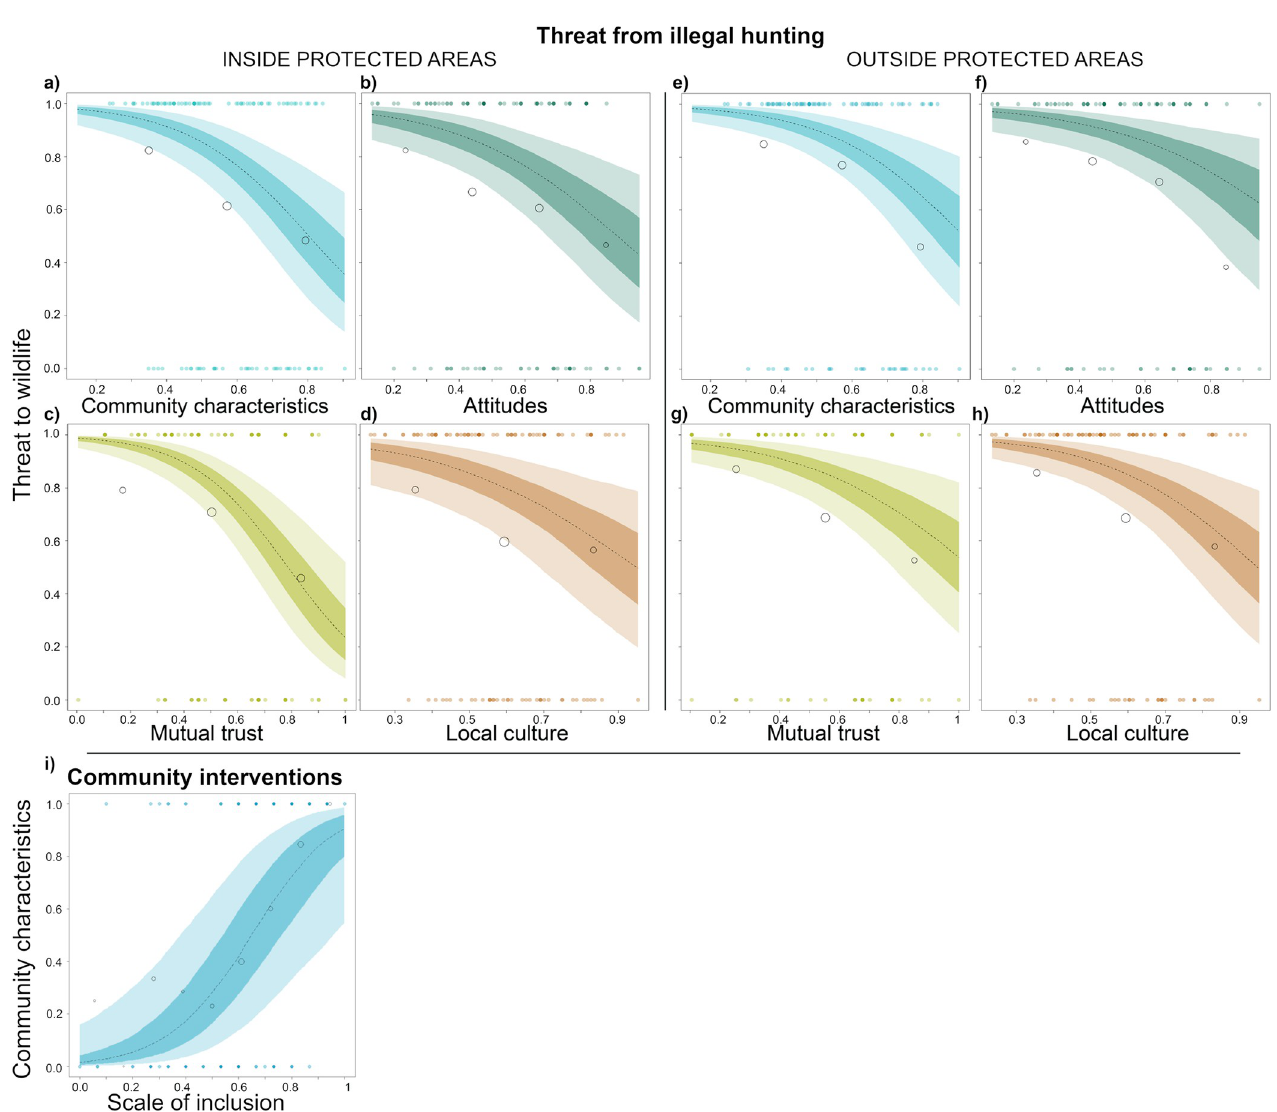
Fig 5. Where people hunt and what mitigates unsustainable hunting. Left panel: probability of high threat to wildlife by illegal hunting (killing/hunting/ poisoning) inside PAs related to (a) community characteristics and the separate components of the index community characteristics, (b) attitudes of local communities towards conservation, (c) mutual trust levels between park management and organisations, and (d) conservation-friendly local culture (the data underlying this figure can be found in S8 Data). Right panel: threat levels outside park boundaries across (e) community attributes, (f) attitudes, (g) mutual trust levels, and (h) local culture (S9 Data). Threat levels decreased equally outside and inside parks, while the effects were more pronounced outside parks. The models, including mutual trust, best explained the results. (i) The scale of inclusion of local communities in decision-making showed a positive relationship with the index community characteristics (S10 Data). The “scale of inclusion” was alongside the “provision of benefits to communities”, “implementation of livelihood projects”, and “awareness creation”, the only predictor that showed an effect. The dashed line depicts the expected mean of the predicted posterior distribution. The coloured areas are the 33% and 66% credibility intervals. Transparent points are binned probabilities. The size of the bubbles corresponds to the respective number of PAs. Filled points are original data.